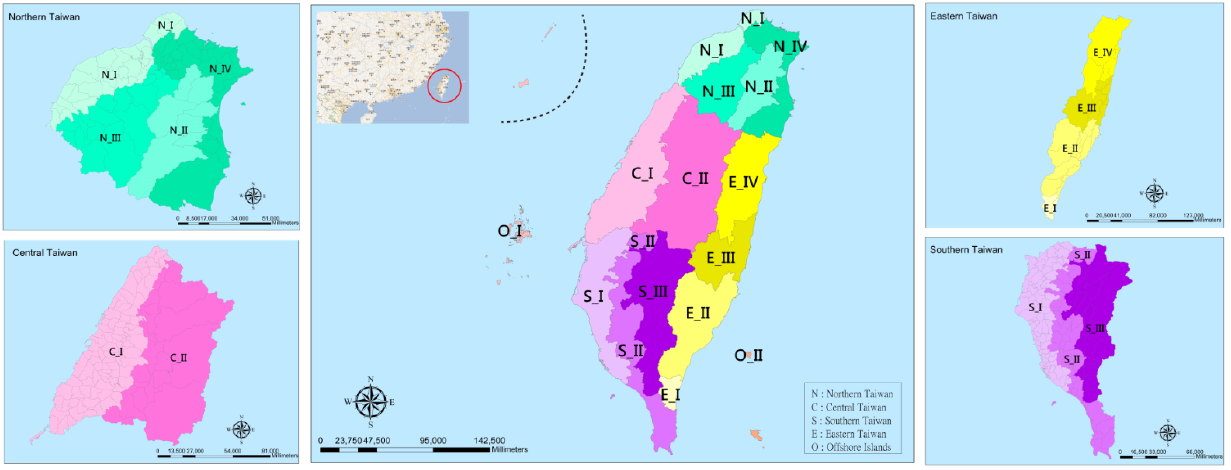
Figure 6. Rainfall zone distribution for national-wide and four